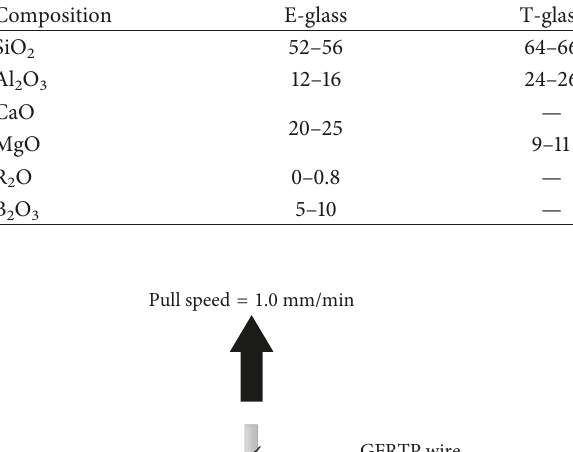
Table 1: Compositions (wt.%) of E-glass and T-glass.